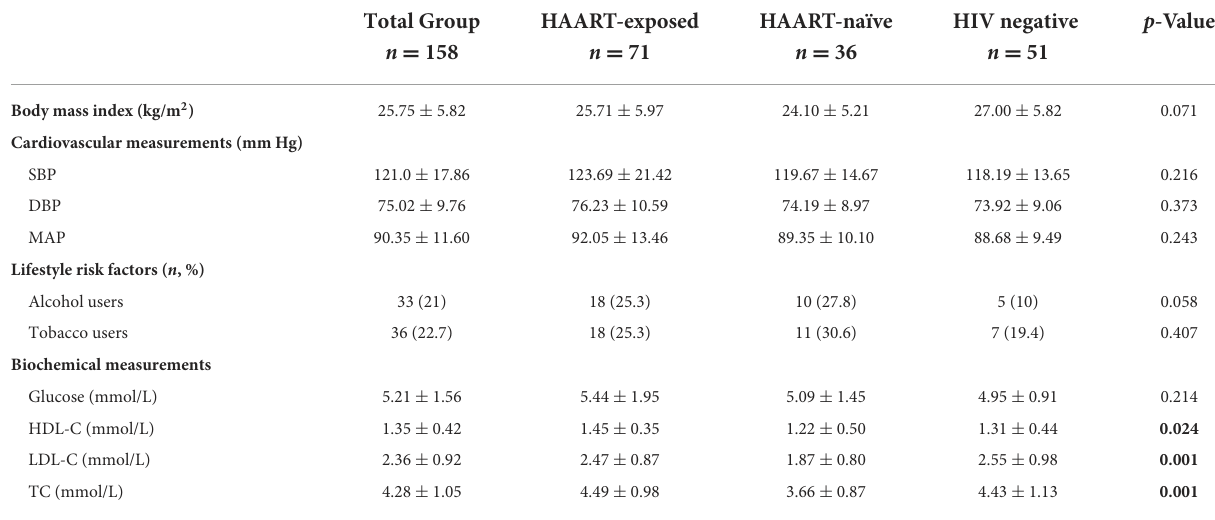
TABLE 3 CVD risk factors of the study